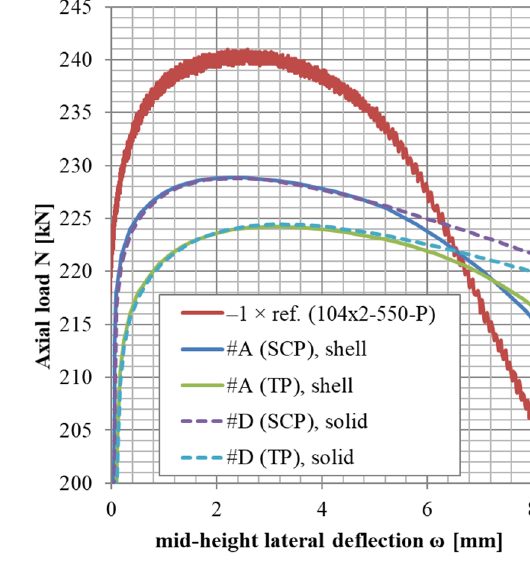
Figure 8. Experimental and FE loads vs. midheight lateral deflection curves of 106 × 3-1650-P [38]: ( a ) whole; ( b ) zoomed. The differences in the matter of the force-deflection curves between modeling ap- proaches #A and #D (shell vs. solid numerical model) are depicted for the selected speci- mens of the cross-sectional set 106 × 3 and 104 × 3 in Figures 7–11. Moreover, in Figures 10 and 11, the results of the approaches #E and #F (different solid element formulations) are also documented and available for comparison.